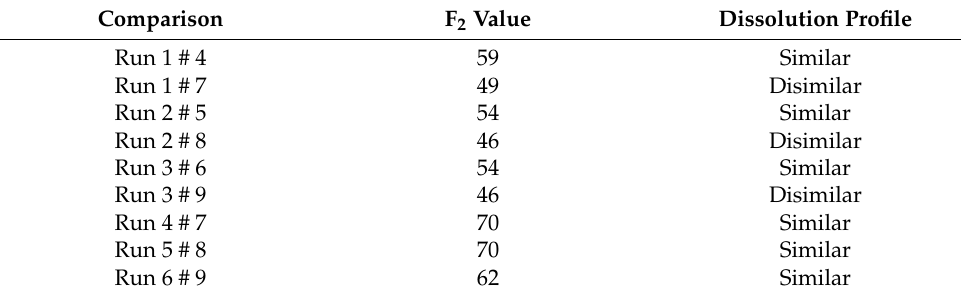
Table 9. Similarity factor (f 2 ) of dissolution profiles of different